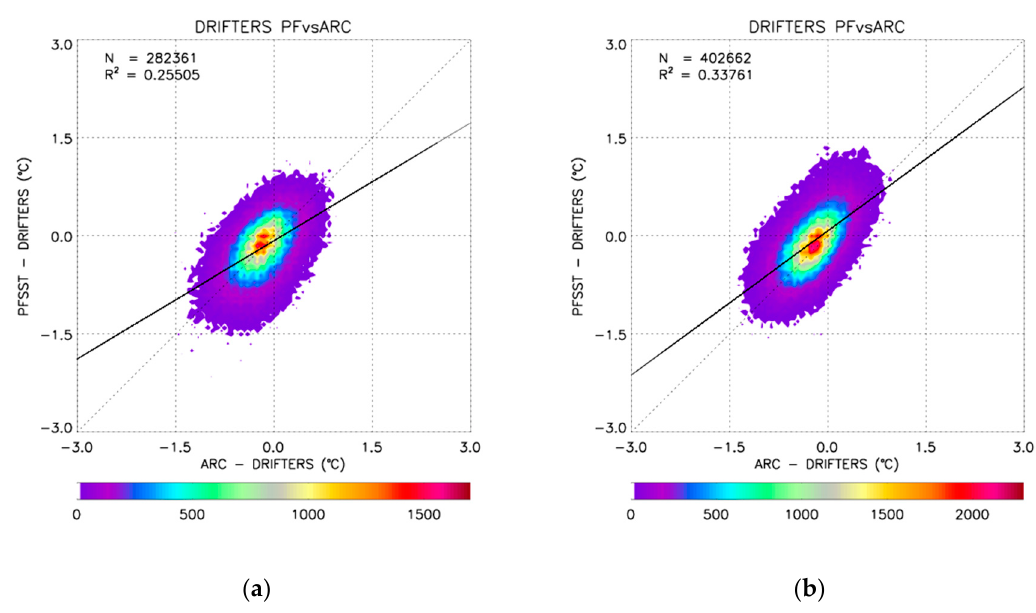
Figure 2. ( a ) nighttime bivariate plot between the PF53-Drifter and ARC-Drifters and ( b ) daytime bivariate plot between the PF53-Drifter and ARC-Drifters.